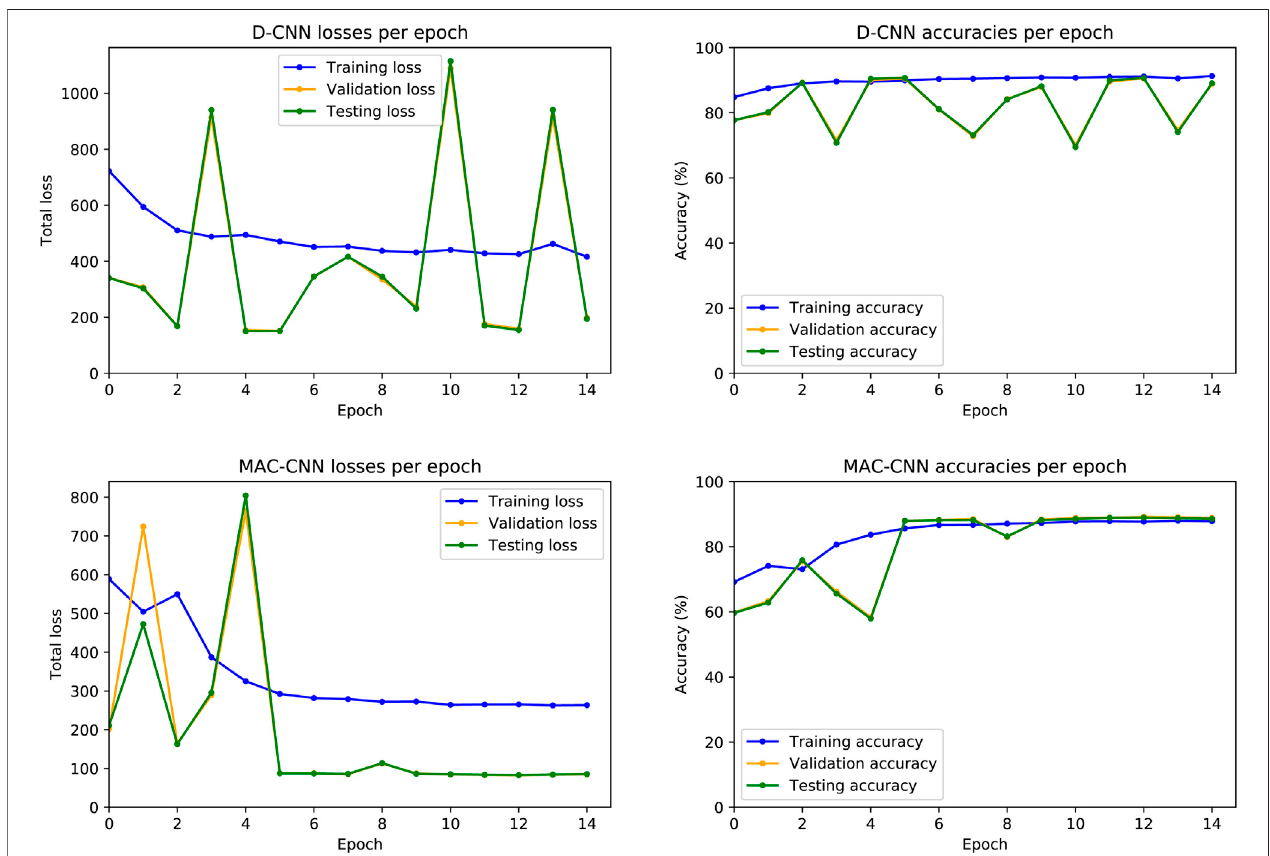
FIGURE4| D-CNNandMAC-CNNlossandaccuraciesperepoch,foronerandomlyinitializedpairofmodels. Thetrainingprocedurealwayssavesthemodelwith the lowest validation set loss, regardless of whether it is from the last epoch. For the D-CNN in this example, the model from epoch 5 is saved, as well as the D matrix it generates on the validation set. For the MAC-CNN in this example, the model from the fi nal epoch (epoch 14) is saved. Saving the lowest-loss model instead of the fi nal model greatly mitigates the potential effects of over fi tting in later epochs.